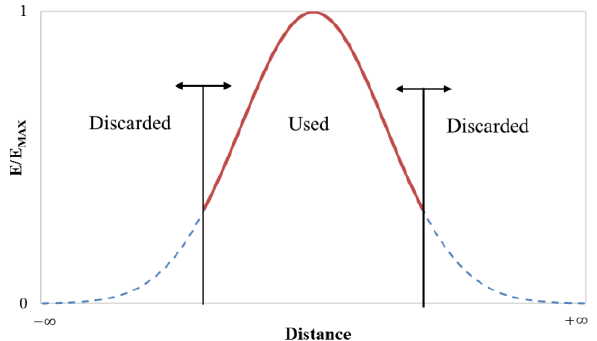
Figure 1. Gaussian distribution received by traditional imaging concentrators.